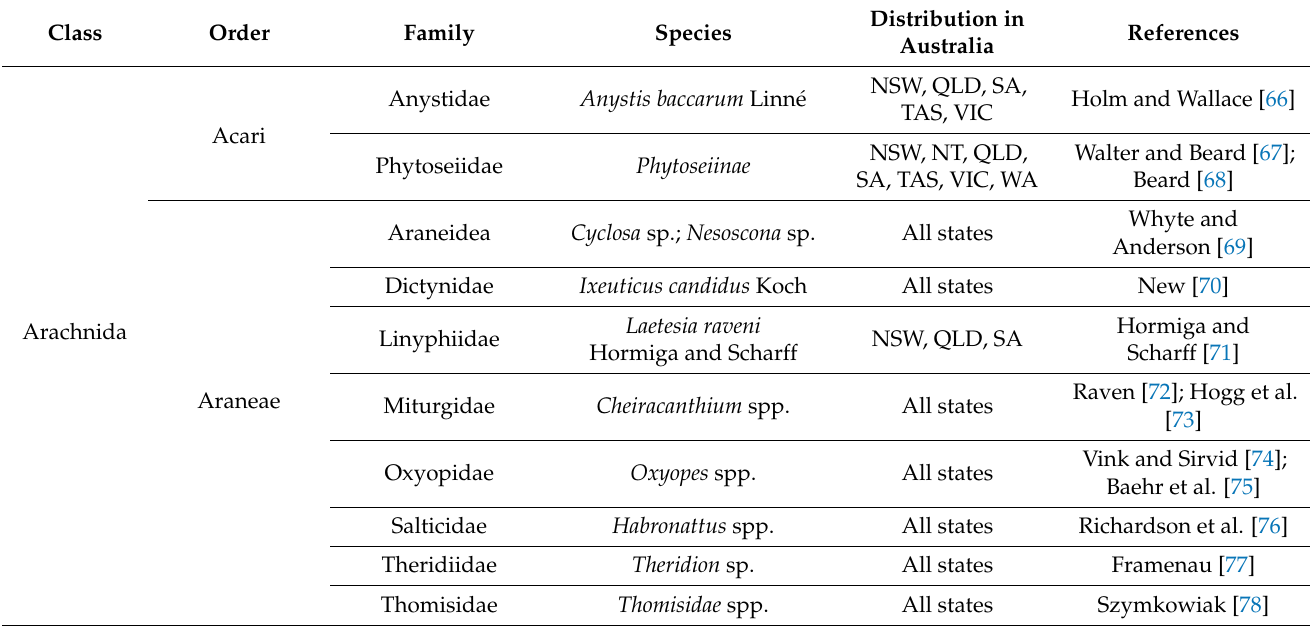
Table 1. Natural enemies that occur in Australia and that have been identified in other countries as preying upon or parasitizing Bactericera cockerelli